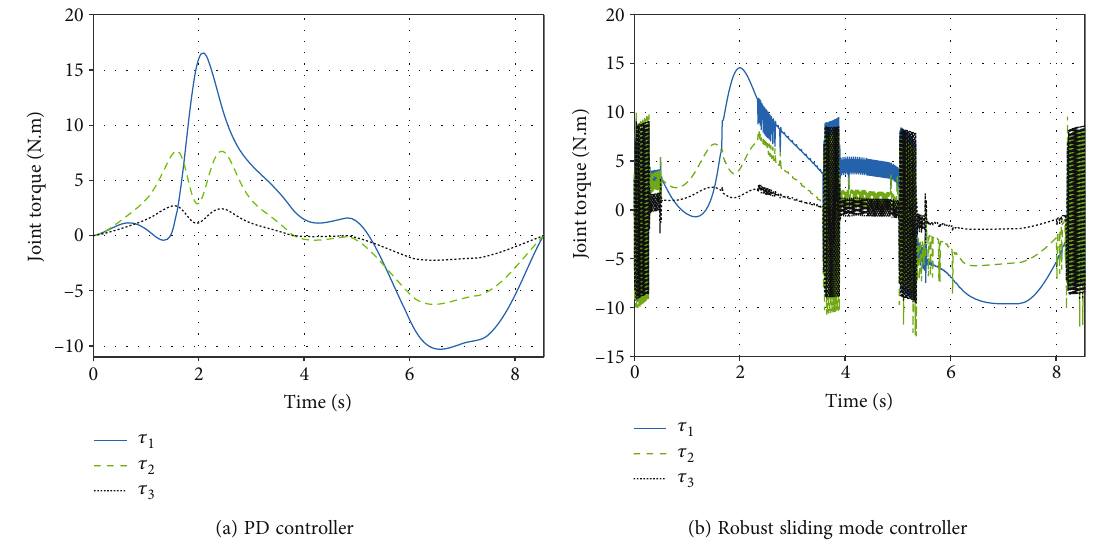
Figure 9: Comparison of joint control torque of the two control